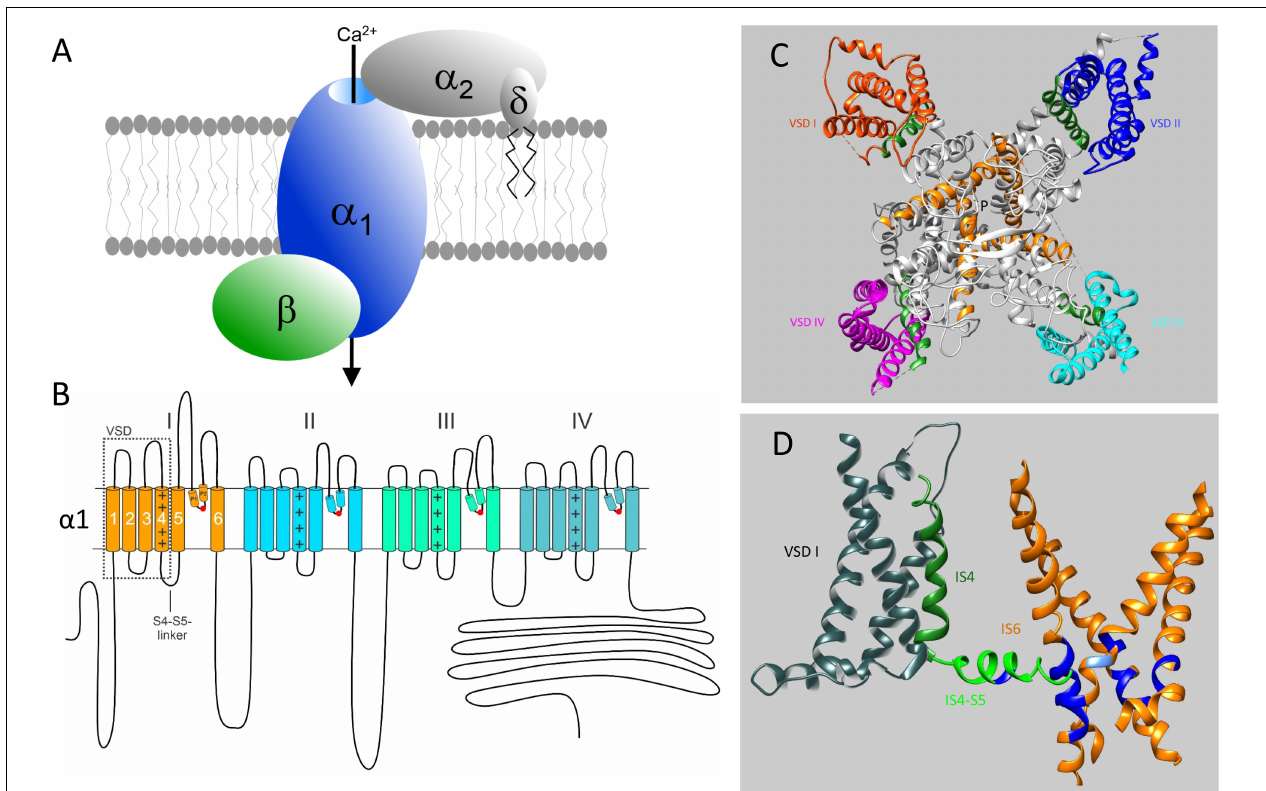
FIGURE 1 | Subunit structure of voltage-gated Ca 2 + channels and their mutation-sensitive regions. (A) The pore-forming α 1-subunit determines most of the biophysical properties of voltage-gated Ca 2 + channels and also carries the binding domains for subtype-selective drugs and toxins. β -and α 2 δ -subunits associate with α 1-subunits of Cav1 and Cav2 channels but not with Cav3 T-type channels. They support channel trafficking to the membrane, fine-tune gating properties but appear to have also channel-independent functions. Here we only discuss pathogenic mutations in α 1-subunit genes. (B) Transmembrane folding topology of α 1-subunits. Four homologous domains (I-IV) each form a voltage sensing domain (VSD, S1-S4; dotted box). The S6 helices together with the connecting S5-S6 linkers of each domain contribute to the formation of a single central Ca 2 + -selective pore. The S4-S5 linkers in each domain transmit the voltage-dependent conformational changes of the S4-helix movements to the cytoplasmic side of the pore by interactions with adjacent S4-S5 – linkers (Hofer et al., 2020) and S6 helices (Wu et al., 2016; Catterall et al., 2020). Mutations neutralizing the voltage-sensing positive charges in each voltage sensor can open an additional ion conducting pathway (termed ω -pore) through the voltage –sensing domain, which can conduct pathogenic gating pore currents (see Figure 5 and text for details). P1 and P2 are helices contributing to the formation of the external part of the pore. They coordinate the formation of the Ca 2 + -selectivity filter formed by four negatively charged amino acid residues indicated by the red circles. (C) Cryo-electron microscopy structure of the Cav1.1 calcium channel complex purified from rabbit skeletal muscle (PDB 5GJV). Only a top view of the pore-forming α 1-subunit is shown to illustrate the position of the four voltage-sensing domains (VSD I – IV, highlighted in different colors). The voltage-sensing positively charged S4 helices of the VSD domains are shown in green (positive charges are not indicated). The central pore-forming region including the intracellular activation gate are formed by the S6 helices indicated in orange. P indicates the ion conducting pathway. The structure is in a presumably inactivated state with S4 voltage-sensors “up” and the activation gate closed (Wu et al., 2016). (D) Most of the missense mutations (in particular GOF mutations) causing Ca 2 + -channelopathies occur in regions important for voltage-dependent channel gating. These functional modules consists of S4 (green) and the cytoplasmic S4-S5 linkers (light green), which are tightly coupled through multiple interactions (not illustrated) to the activation gate formed by the four S6 helices (orange). For clarity the VSD (gray), S4 and S4-S5 linker are only shown for domain I together with all 4 S6 helices (orange). Positions where pathogenic mutations occur in all Cavs ( Figures 3 , 4 ) are indicated in blue. In IS4-S5 this represents the position of the FHM1 mutation S218L ( CACNA1A ) and the CSNB2 mutation S229P ( CACNA1F ), which both cause GOF (type 2 gating; see text for details). The position of the Timothy Syndrome mutation G402R/S ( CACNA1C ) is indicated in light blue. Note that pathogenic GOF mutations at the same position also occur in Cav1.3, Cav1.4, and Cav2.3 ( Figure 3 ). The schemes in (C,D) were generated using UCSF Chimera 1.13.1 (Pettersen et al., 2004). The position of mutations in the Cav1.1 α 1-subunit is shown based on the sequence alignments in Figures 3 , 4 and does not account for potential differences in the folding structure of the different α